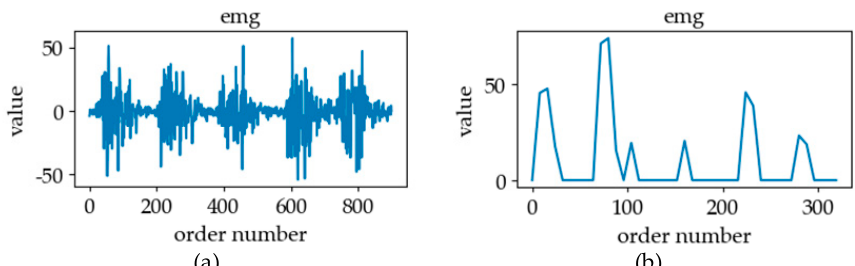
Figure 12. Wavelet variation of the sEMG signal. ( a ) the original sEMG image and ( b ) the transformed image.